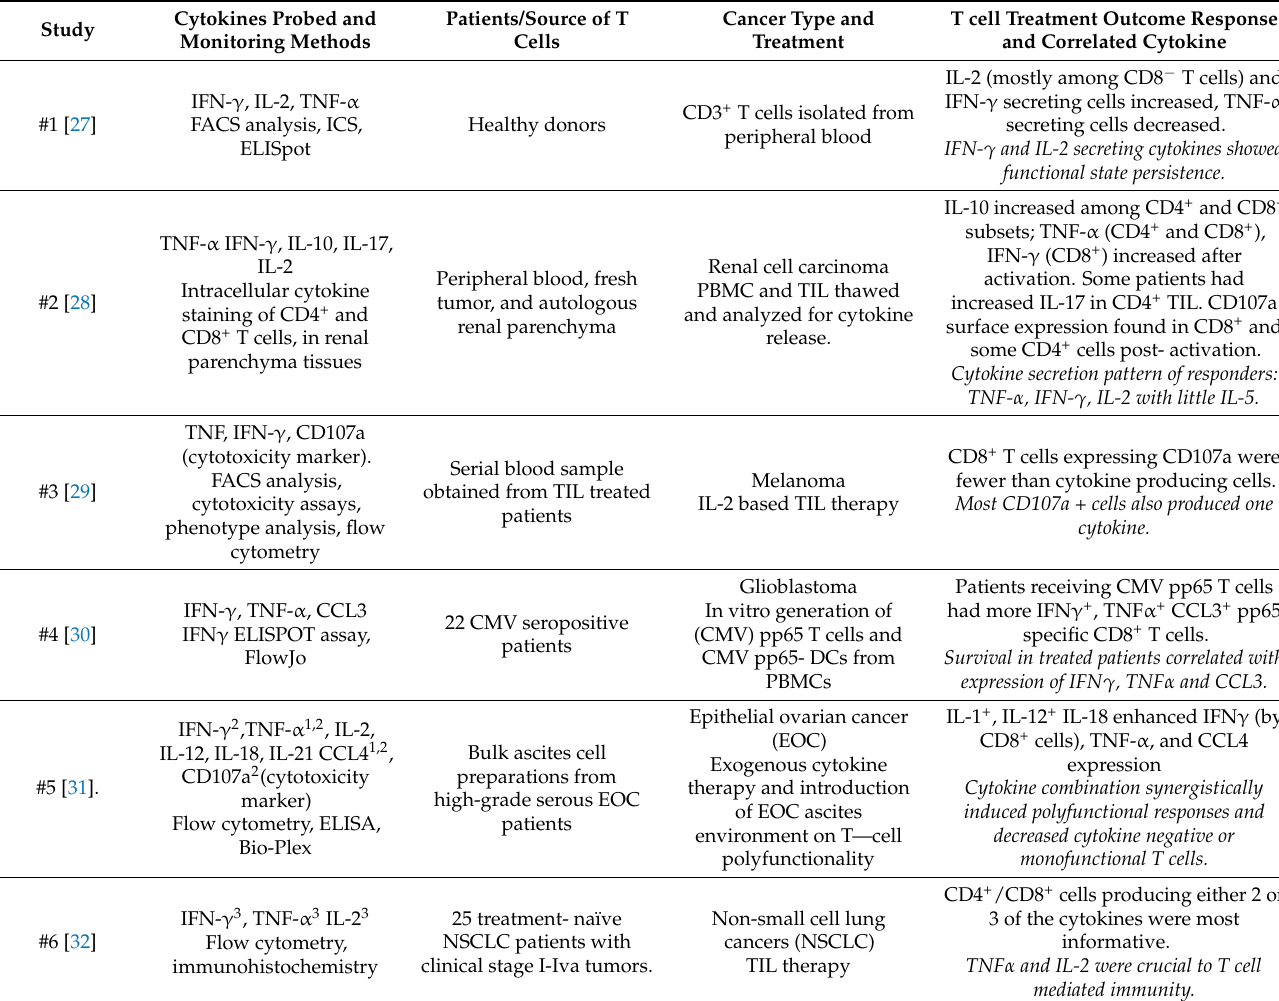
Table 1. Correlating cytokine profiles and T cell